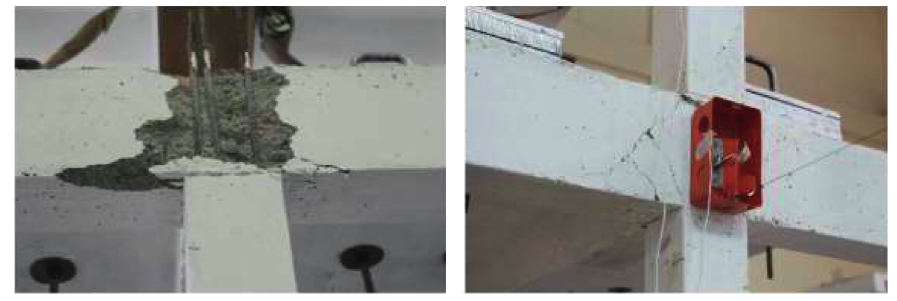
Figure 5: Observed damages in Model-2 (refer Table 2 for damage evolution; figure is reproduced from Ahmad et al.